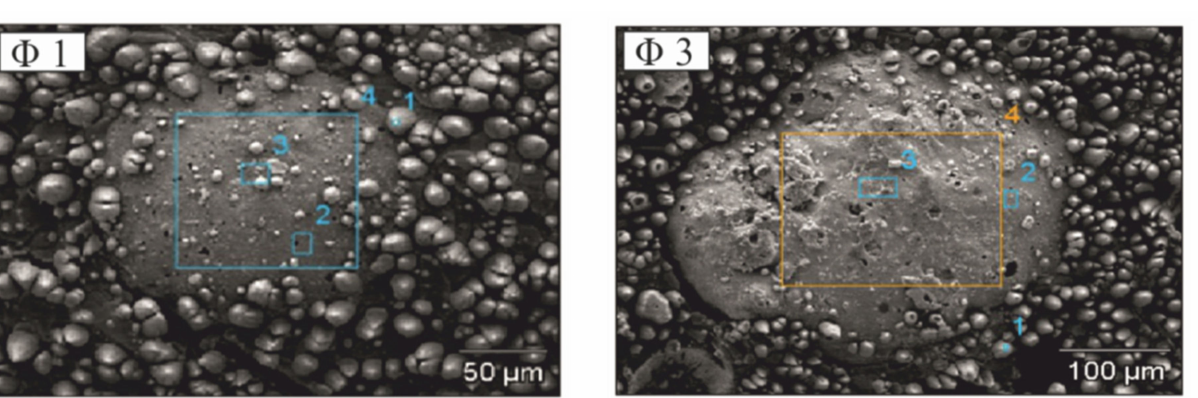
Figure 7. SEM images with rectangular areas on glass microspheres Φ 1, Φ 3 in coatings, where the amount of copper was examined by the EDX